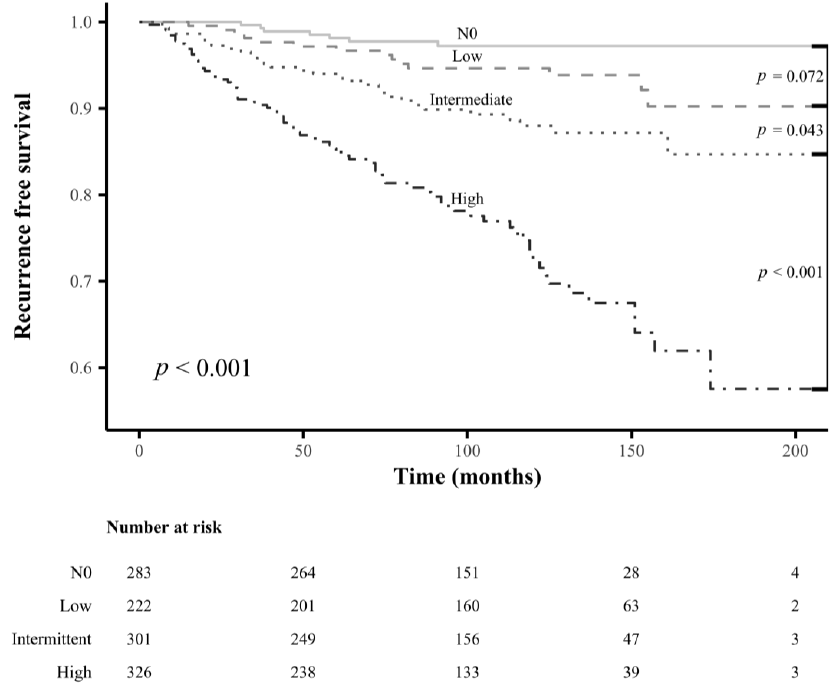
Figure 6. Comparison of the recurrence-free survival rates between pathologic N0 patients and pathologic N1 patients classified into the newly developed lymph node-related risk categories after 1:3 propensity score matching.